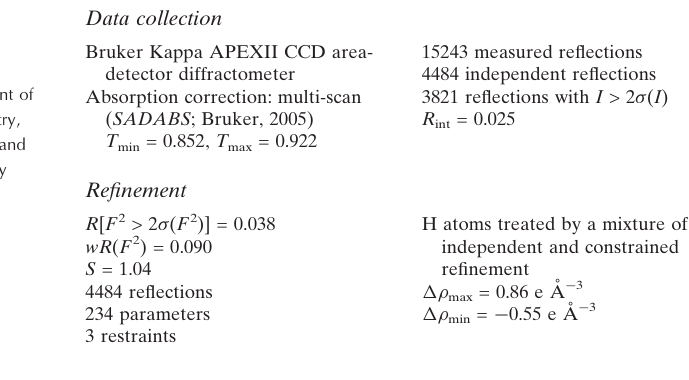
the centrosymmetric mononuclear complex,